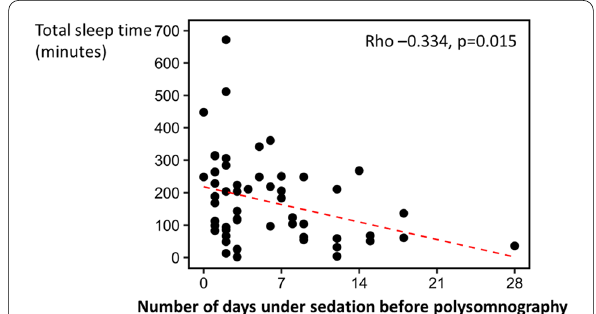
Fig. 2 The duration of sedation before polysomnography ( X axis) and total sleep time ( Y axis) were significantly correlated (Rho p 0.015) meaning that the longer the duration of sedation before = polysomnography, the shorter the total sleep